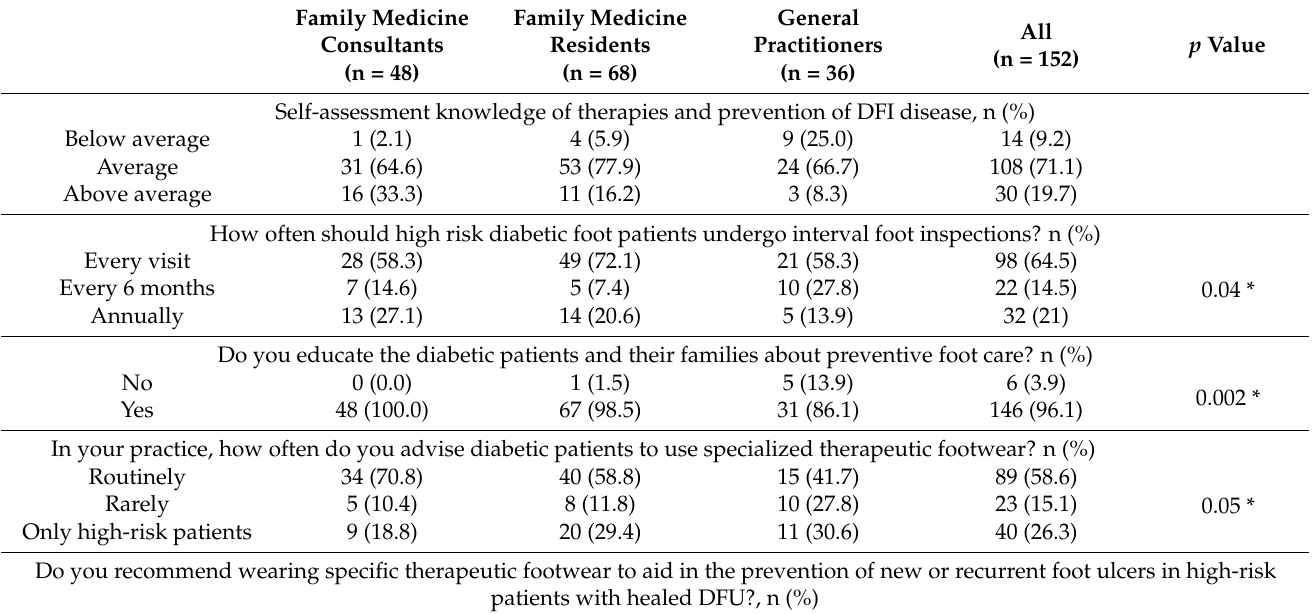
Table 3. Participants’ understanding and attitude toward prevention of DF ulceration in diabetic